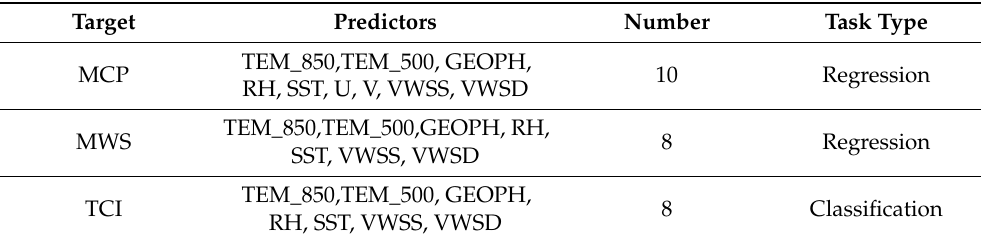
Table 1. The targets and their